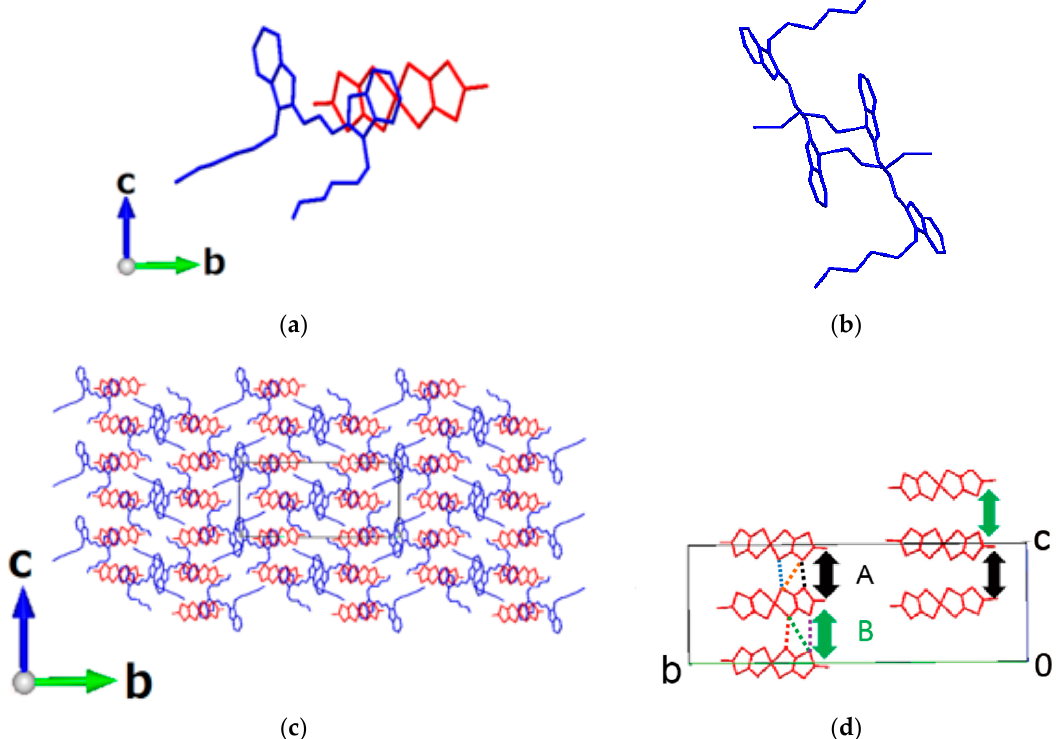
Figure 2. Crystal structure of δ -DiCC[Ni(dmit) 2 ]. Red; Ni(dmit) 2 anon, blue; DiCC cation, hydrogen atoms are omitted for clarity: ( a ) asymmetric unit; ( b ) neighboring cation arrangement; ( c ) view down along a -axis; ( d ) interaction between anions in the bc -plane. In ( d ), the sulfur–sulfur distances between the two anions designated by broken lines are 3.747(2) (blue), 3.519(2) (orange) and 3.656(2) Å (black) in the intermolecular relation A and 5.312(2) (red), 4.474(2) (green) and 3.819(2) Å (violet) in the relation B, respectively.